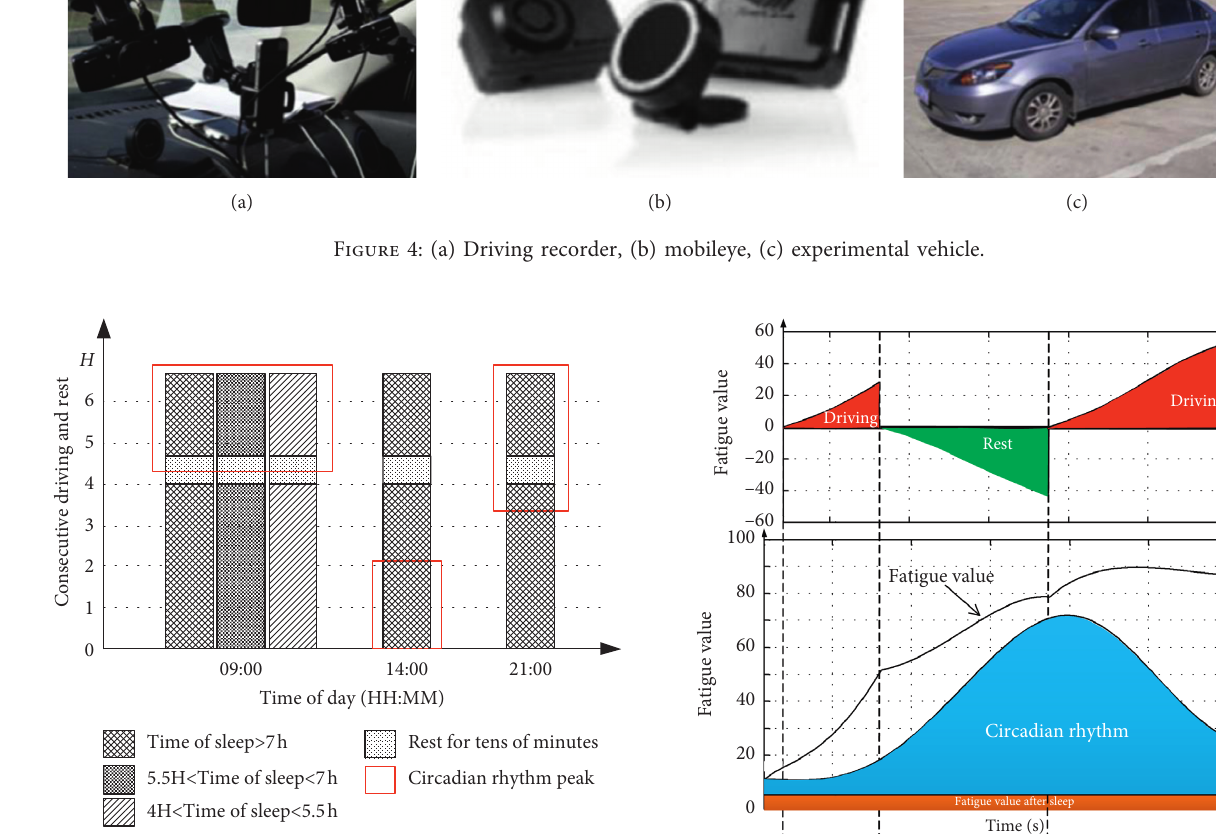
Figure 5: Participants’ schedule statistics.